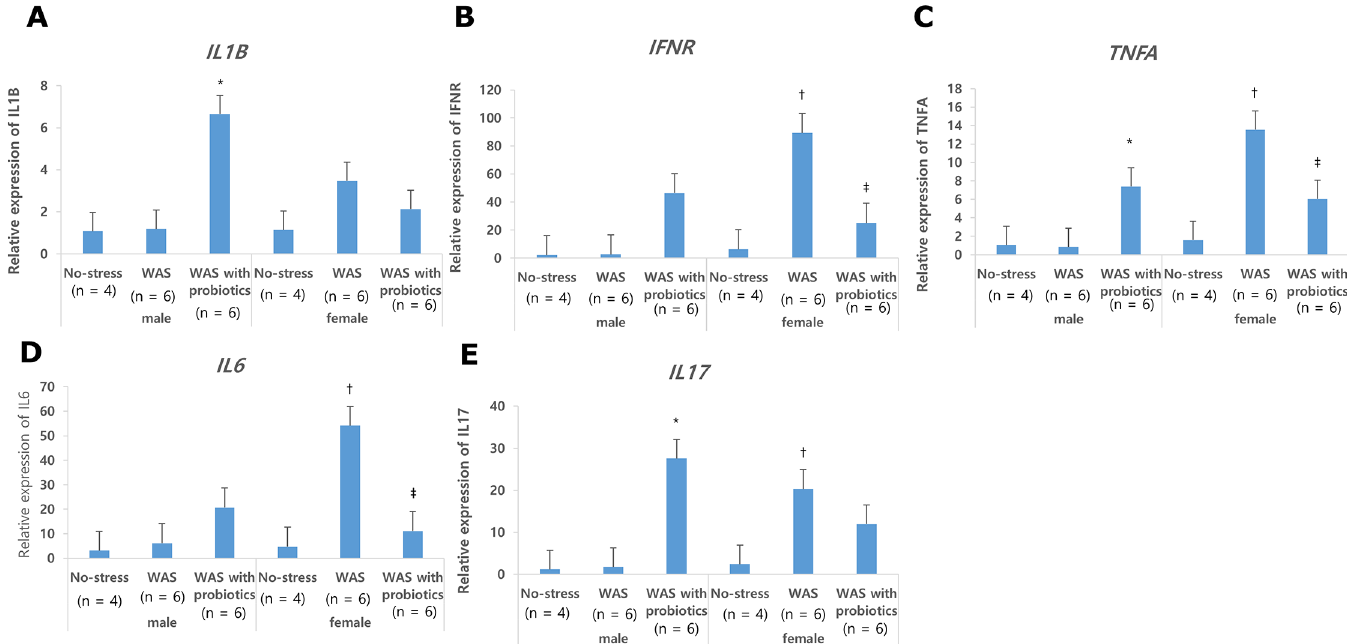
Fig 5. Colonic mucosal mRNA expressions. (A) Mucosal qPCR expressionof interleukin-1 β ( IL1B ) in distal colon was significantly higherin male rats of the water avoidance stress (WAS) group with probiotics group than in those of the male WAS group. (B, C, D)Mucosal interferon- γ ( IFNR ), tumor necrosis factor- α ( TNFA ), IL6 expressionin distal colon was significantly higherin female rats of the WAS groupsthan in those of the male rats and significantly decreased only in female rats of the WAS with probiotics group. (E)Mucosal qPCR expressionof IL17 in distal colon was significantly higherin male rats of the WAS group with probiotics group than in those of the male WAS group. Data are expressedas means ± SEM. * P < 0.05 comparedwith no-stress and WAS group in male; † P < 0.05 comparedwith female no-stress group; ‡ P < 0.05 comparedwith female WAS group.